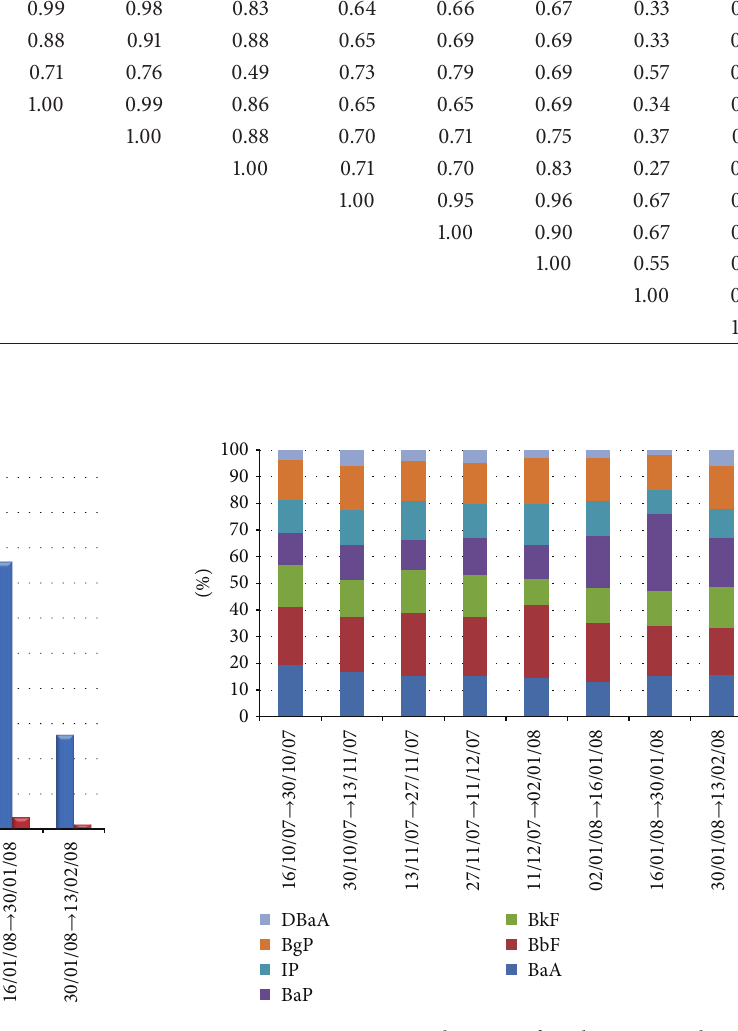
Figure 4: Percentage contributions of each PAH to the total deposition fluxes at the industrial